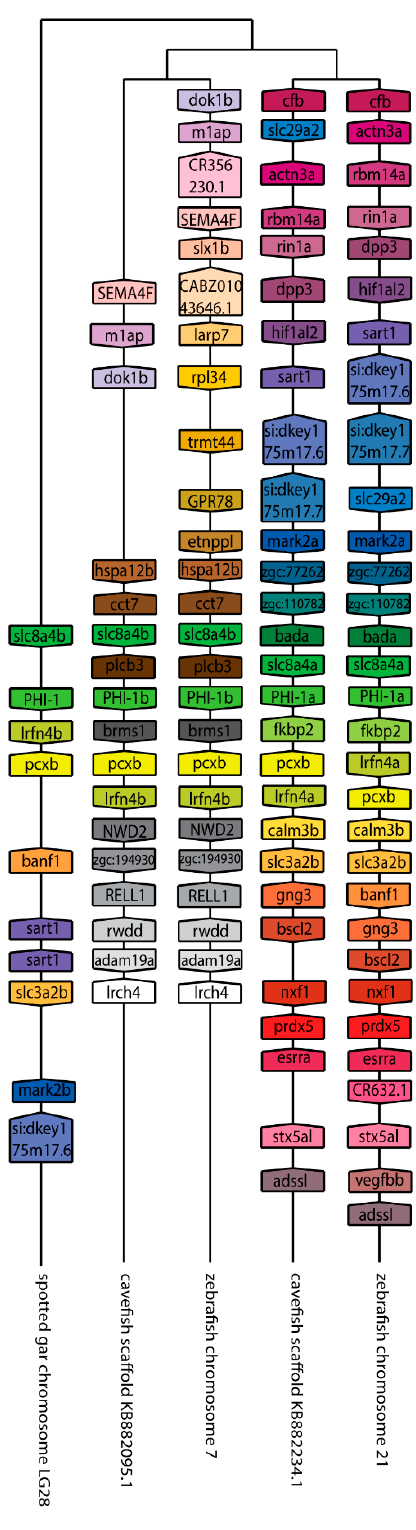
Figure 4. The genomic organization of the ppp1r14b paralogs in zebrafish. Genomicus was used to analyze ppp1r14b synteny between Danio rerio (zebrafish), and the most closely related sequenced relative, Astyanax mexicanus (cavefish) . Lepisosteus oculatus (spotted gar) was used as an outgroup. Homologous genes are shown with matching coloration, and the gene direction on the chromosome is indicated by the direction of the boxed arrow. Species and chromosome numbers are noted. We next undertook a phylogenetic analysis of the ppp1r14a and ppp1r14b genes in fish. Trees were generated in IQ-TREE using the maximum likelihood method, and were re-rooted with